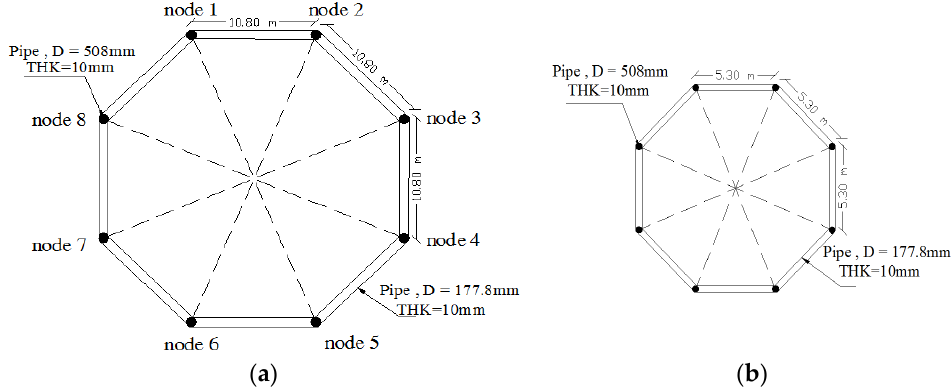
Figure 2. ( a ) Arrangement of the columns and beams under the tank tower support; ( b ) arrangement of the columns and beams at the bottom of the tank. Table 1. Profile sections tank tower (mm).